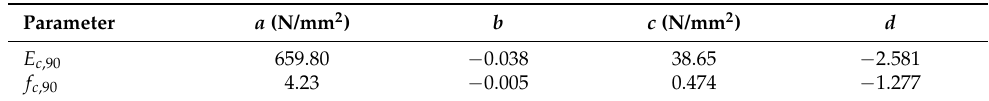
Table 9. Coefficients of regression curves shown in Figure 13 according to Equation (8) for E c ,90 , f c ,90 as a function of wall-to-floor thickness ratio, t w / t f .